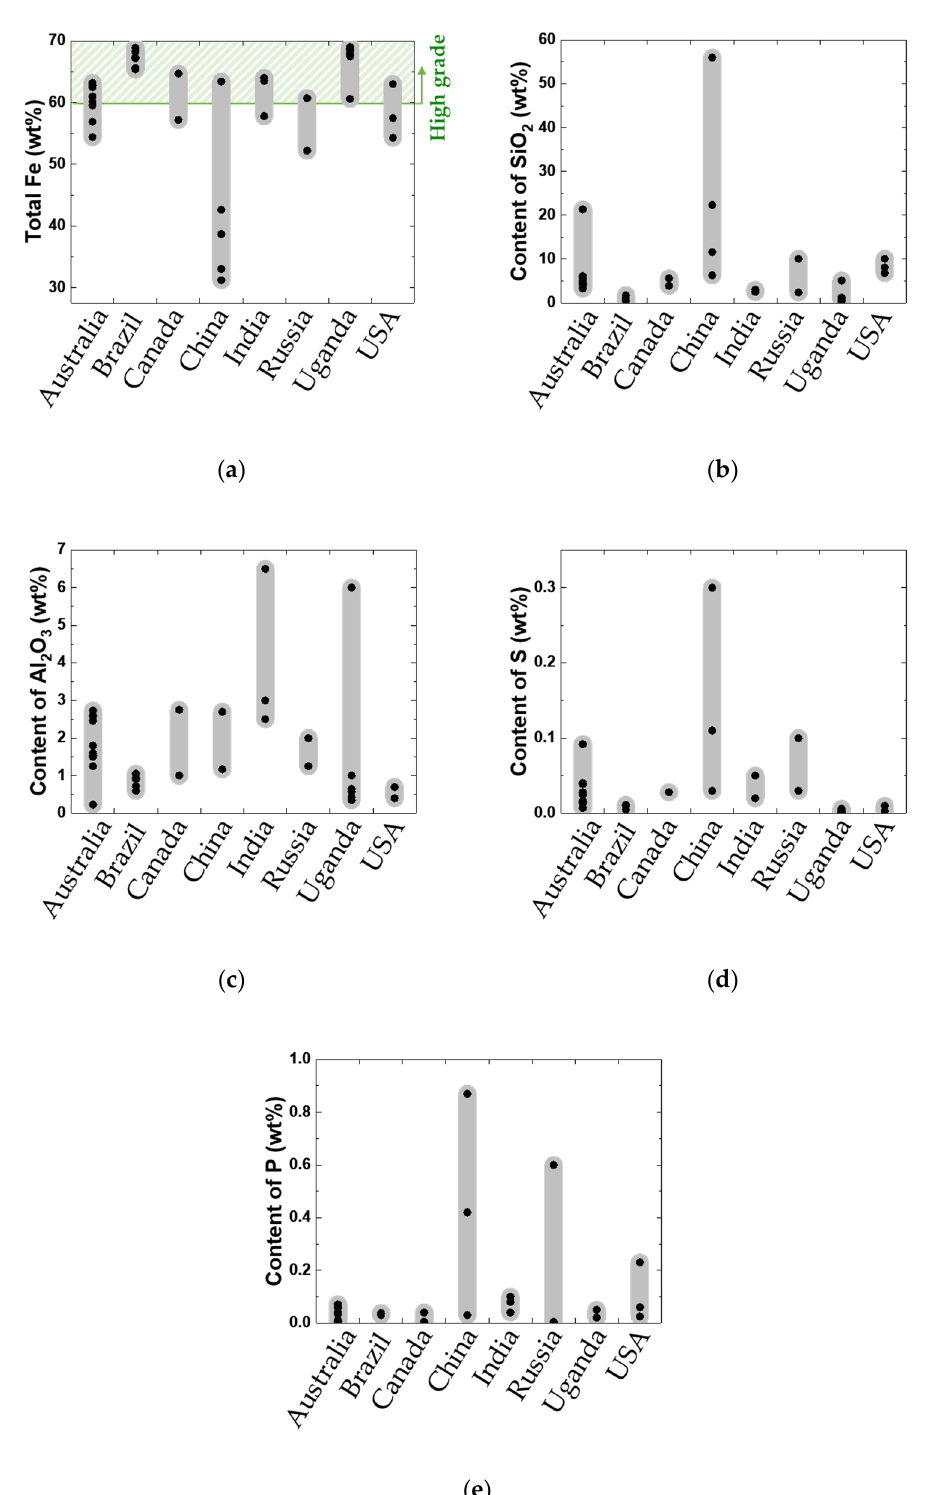
Figure 1. Comparison of chemical compositions of iron ores in different nations: ( a ) Total Fe, ( b ) SiO 2 , ( c ) Al 2 O 3 , ( d ) S, and ( e ) P content.